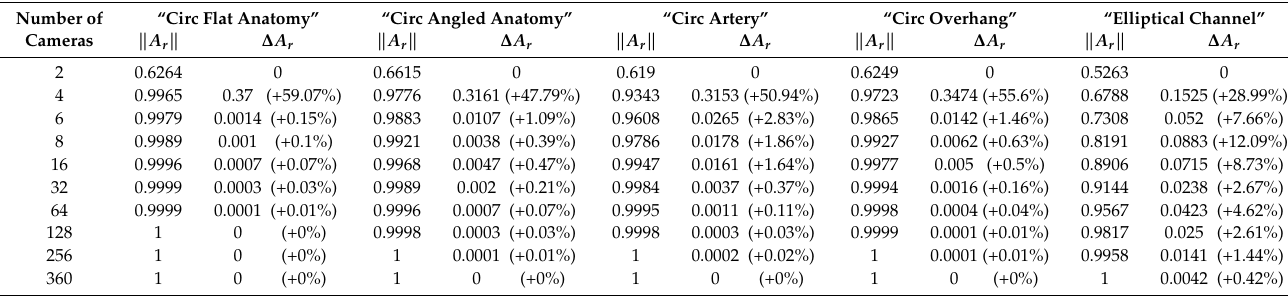
Table 4. Reconstructable areas ( A r ) of the 50mm channel models for different numbers of cameras, excluding the top surface. The area values for each mesh are normalized to the area of the respective mesh which is reconstructable with 360 cameras. ∆ A r denotes the increase in reconstructable area from the previous smaller number of cameras. Number of “Circ Flat